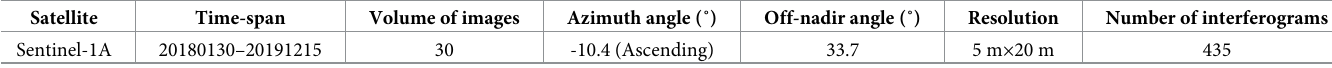
Table 1. The SAR datasets